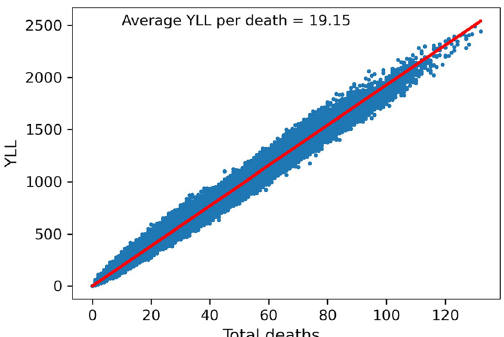
Fig. 12 Scatter plot comparing deaths with YLL for each simulation in the analysis (blue dots) along with a best fit line (red) that has a slope of 19.15